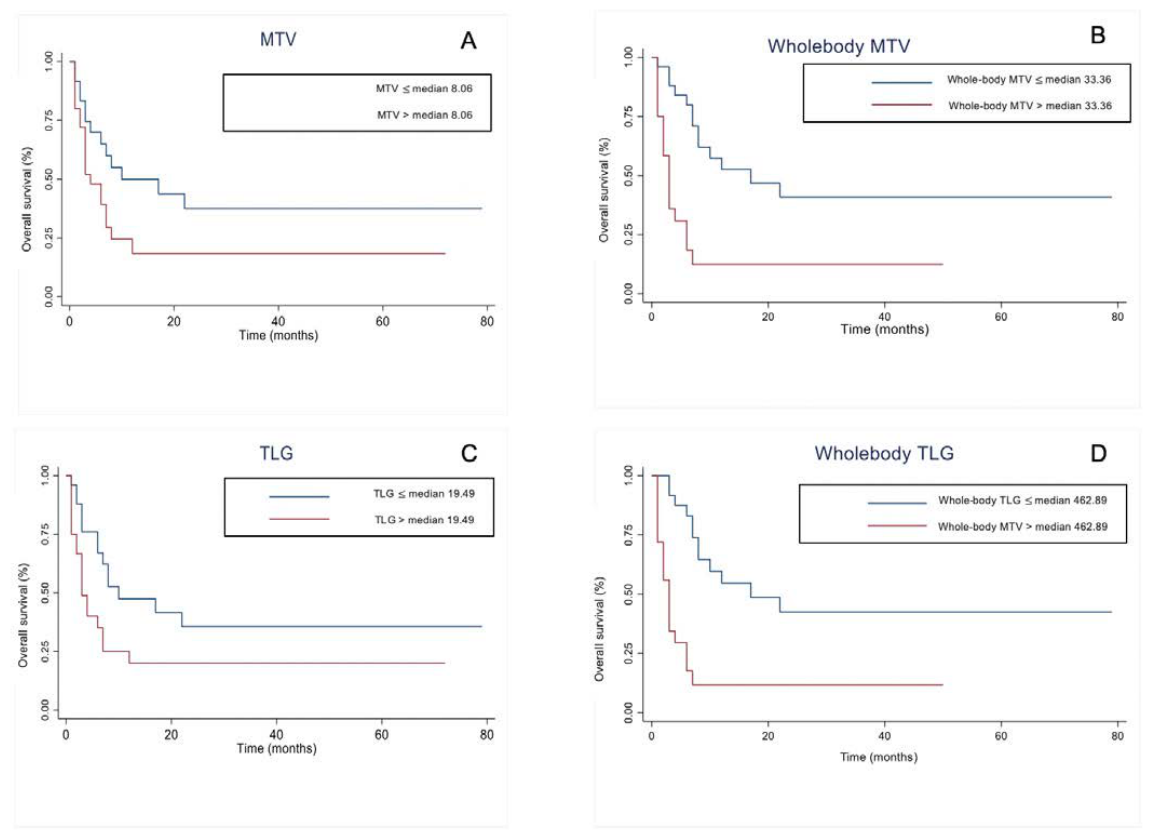
Figure 2. Kaplan–Meier curves for overall survival in restaging melanoma with respect to metabolic tumor volume (MTV) ( A ), whole-body MTV ( B ), total lesion glycolysis (TLG) ( C ), and whole-body TLG ( D ).